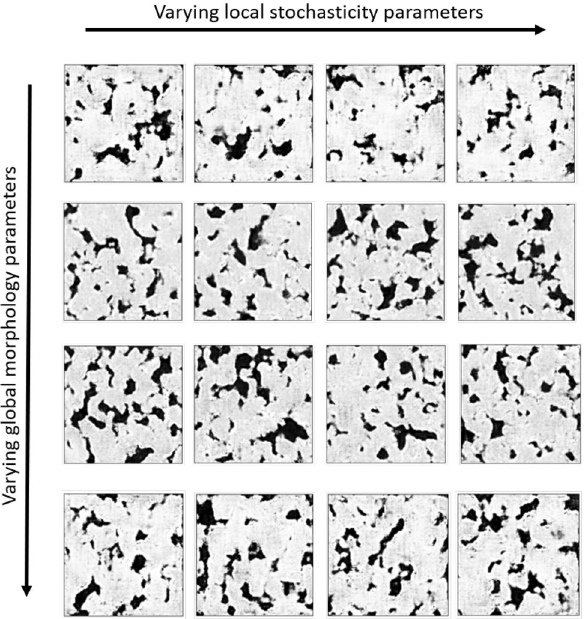
Figure 5. Effects of the local stochasticity parameter ρ . All images are 2D slices of synthetic microstructures taken by cutting planes at the same height position. Microstructures in the same row have the same morphology parameters but different local stochasticity parameters. As can be seen, their overall “style” is maintained and there are only subtle differences between microstructures slice